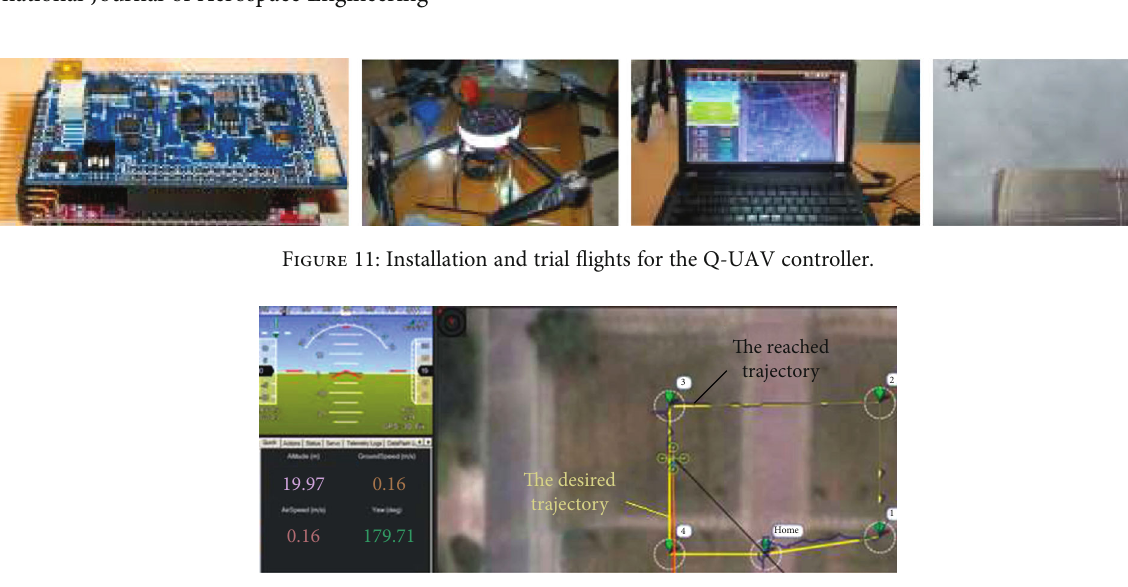
Figure 12: The Q-UAV reached and followed a desired polygon-shaped trajectory with heading angles of about 90 ° and 110 ° .